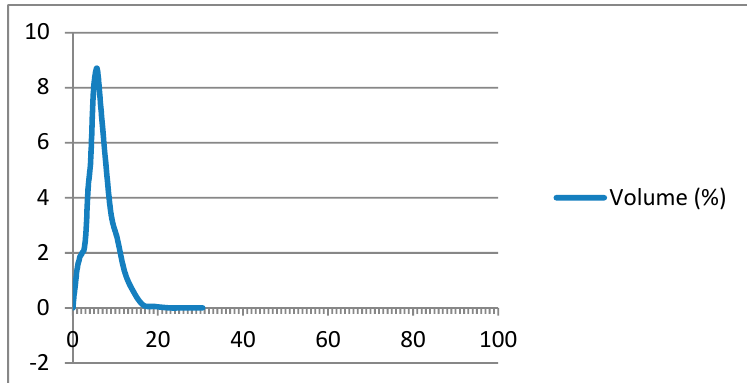
Figure 6. In situ microcapsule size distribution by volume (%).